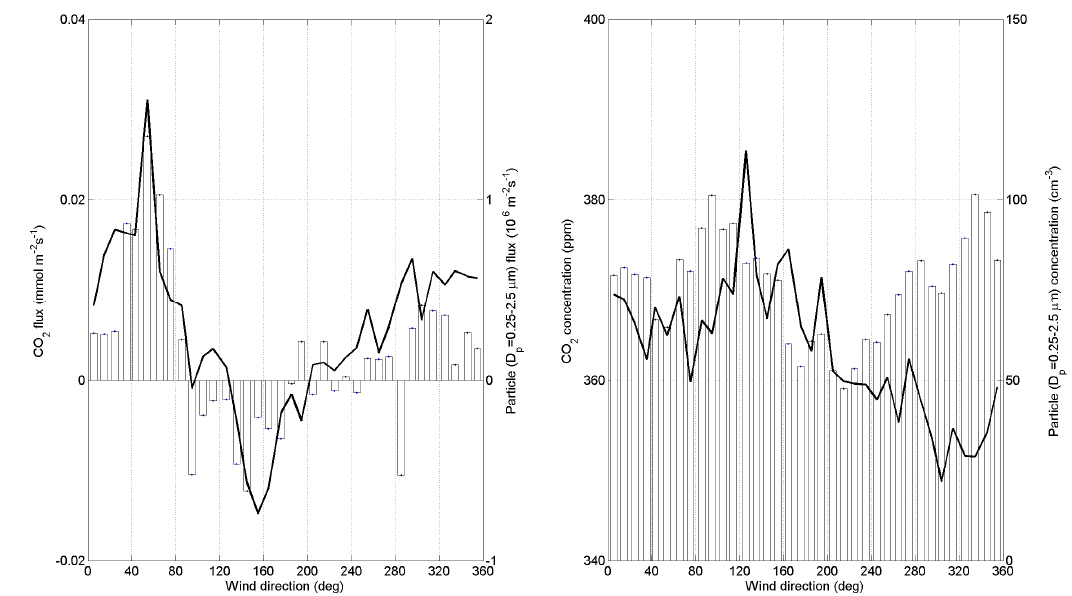
Fig. 2. (a) Aerosol number and CO 2 flux and (b) particle and CO 2 concentrations in wind sector intervals. Bars represent CO 2 flux and concentrations. Solid line: aerosol number flux and particle concentration. Fig 2 : (a) Aerosol number and CO flux and (b) particle and CO concentrations in wind sector 2 2 intervals. Bars represent CO flux and concentrations. Solid line: aerosol number flux and 2 particle concentration.